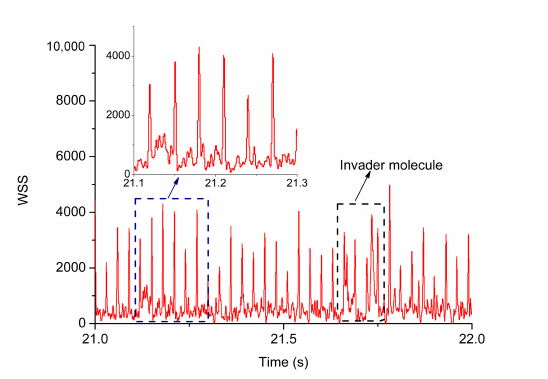
Figure 6. WSS of a fluosphere that diffuses through the capillary and is recycled by a piezo stage. The inset illustrates the intervals between fluorescence peaks, which center around reversal delay, 30 ms and are differed from error induced by diffusion. The black box around 22.7 s describes a second molecule diffuses to the region of recycling and disrupts the detection of passing times. region of